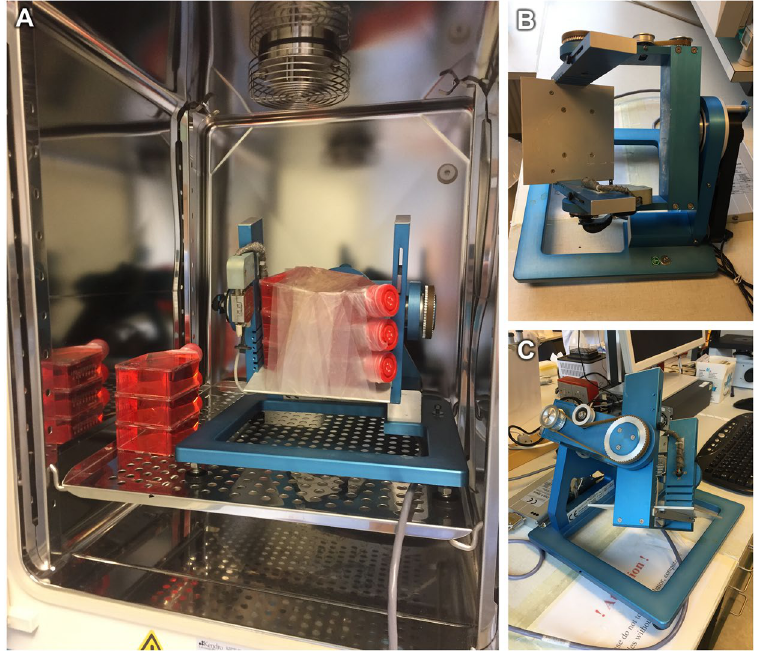
Figure 9. Table-top random positioning machine: Mounted cell culture flasks for RPM-experiments with adjacent 1 g- control flasks in an incubator ( A ). RPM-frame without mounted flasks ( B , C